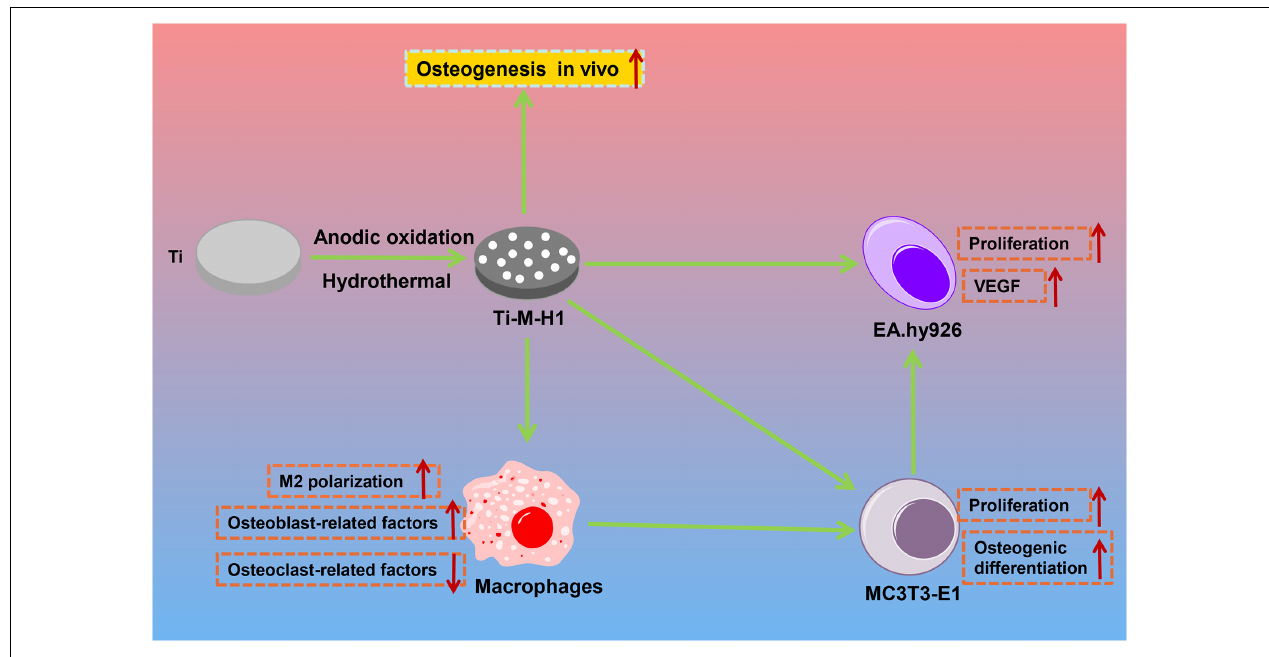
FIGURE 6 | The mechanism graph of the nano-HA forms nanoparticles or nano-rods onto the microporous Ti surfaces. The nano-HA-coated Ti–M–H1 not only induces the osteogenesis and angiogenesis in vitro but also enhances the polarization of macrophage toward M2 to regulate the osteoimmune